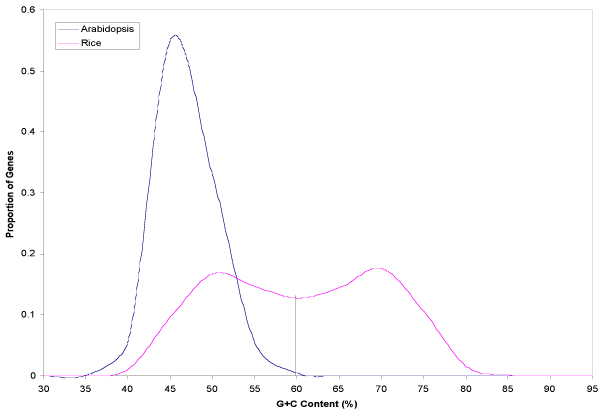
The distribution of GC contents in rice and Arabidopsis genes. The GC content of the 14,005 rice genes (shown in red) has a bimodal distribution, while the GC distribution of the 25,625 Arabidopsis genes (shown in blue) is unimodal. The vertical line (at 60% G+C) shows the point where we separated the rice genes into two classes: high GC and low GC rice genes.